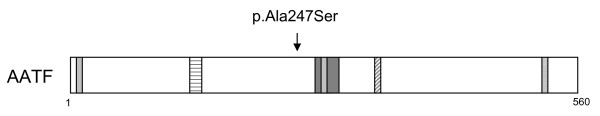
Schematic diagram of AATF protein structure and location of observed missense variant. Structure and main functional domains of AATF are shown. Leucine zipper motif location (aa 275-296) is marked in dark grey, with the basic domain in horizontal stripes (aa 133-145). Nuclear translocation signal is shown in diagonal stripes (aa 338-344). Three nuclear receptor binding motifs are marked in light grey (aa 11-15, 281-285, 520-524). The location of the observed amino acid alteration is shown by an arrow (functional domain structure modified mainly from reference [9]).